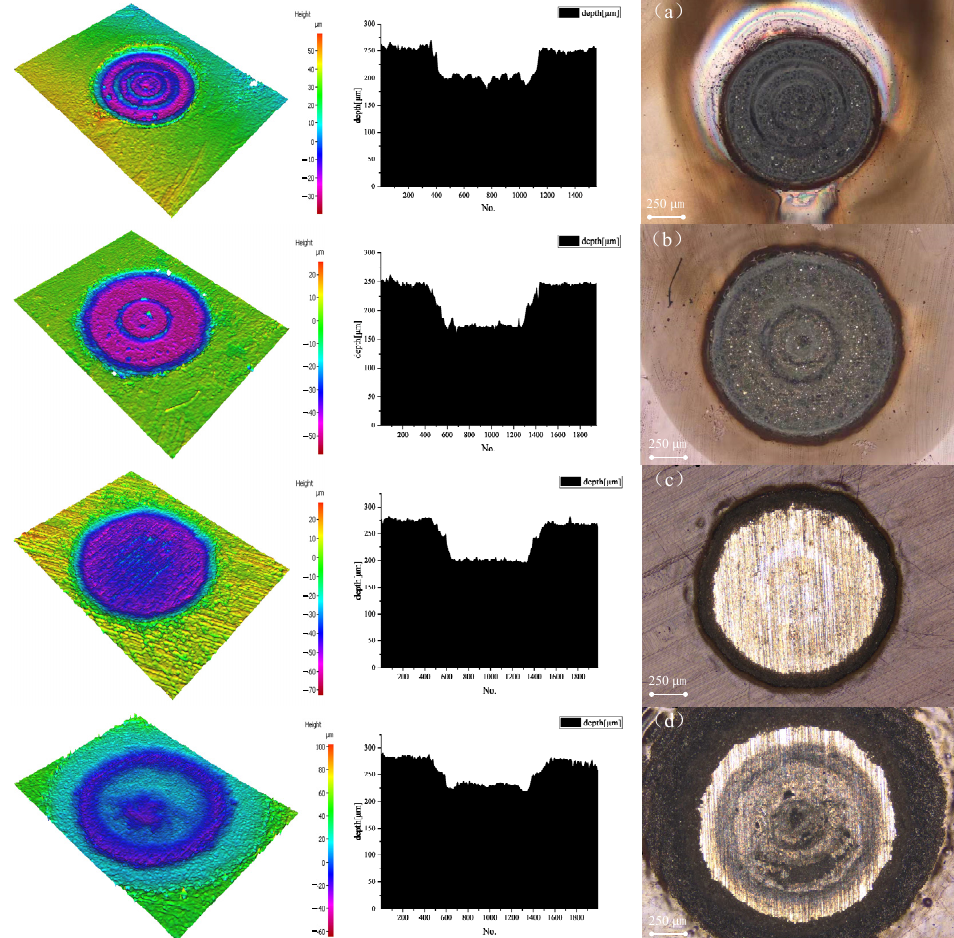
Figure 9. Cleaning effects under different power densities. ( a ) 24.88 W/mm 2 , ( b ) 43.04 W/mm 2 , ( c ) 147.44 W/mm 2 and ( d ) 326.84 W/mm 2 .